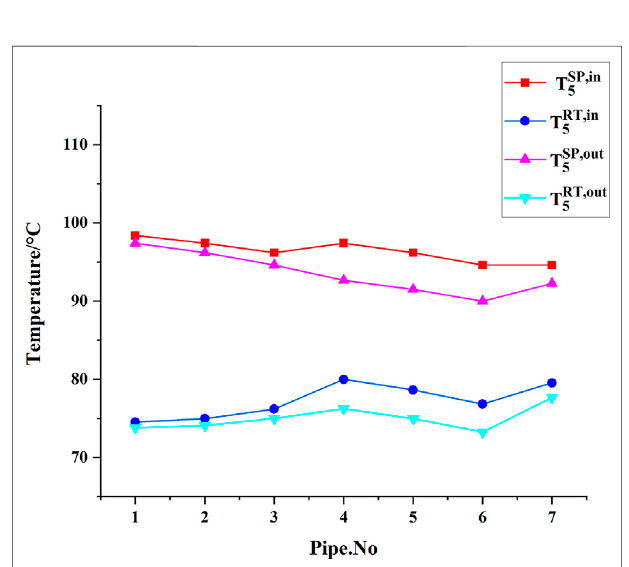
FIGURE 13 | The temperature of supply and return system at off- peak time.